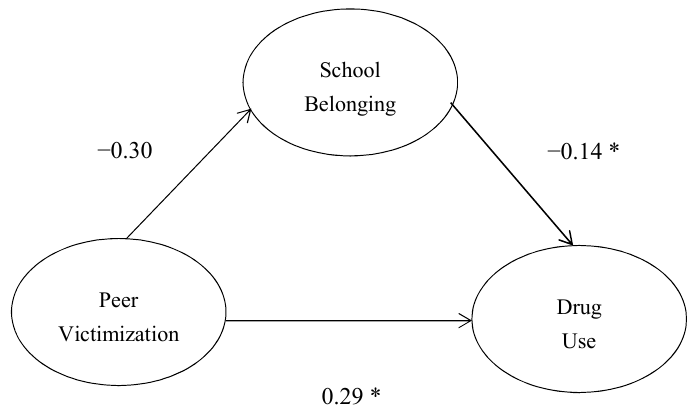
Figure 2. Structural equation model with latent variables and standardized estimates; * = p < 0.001.